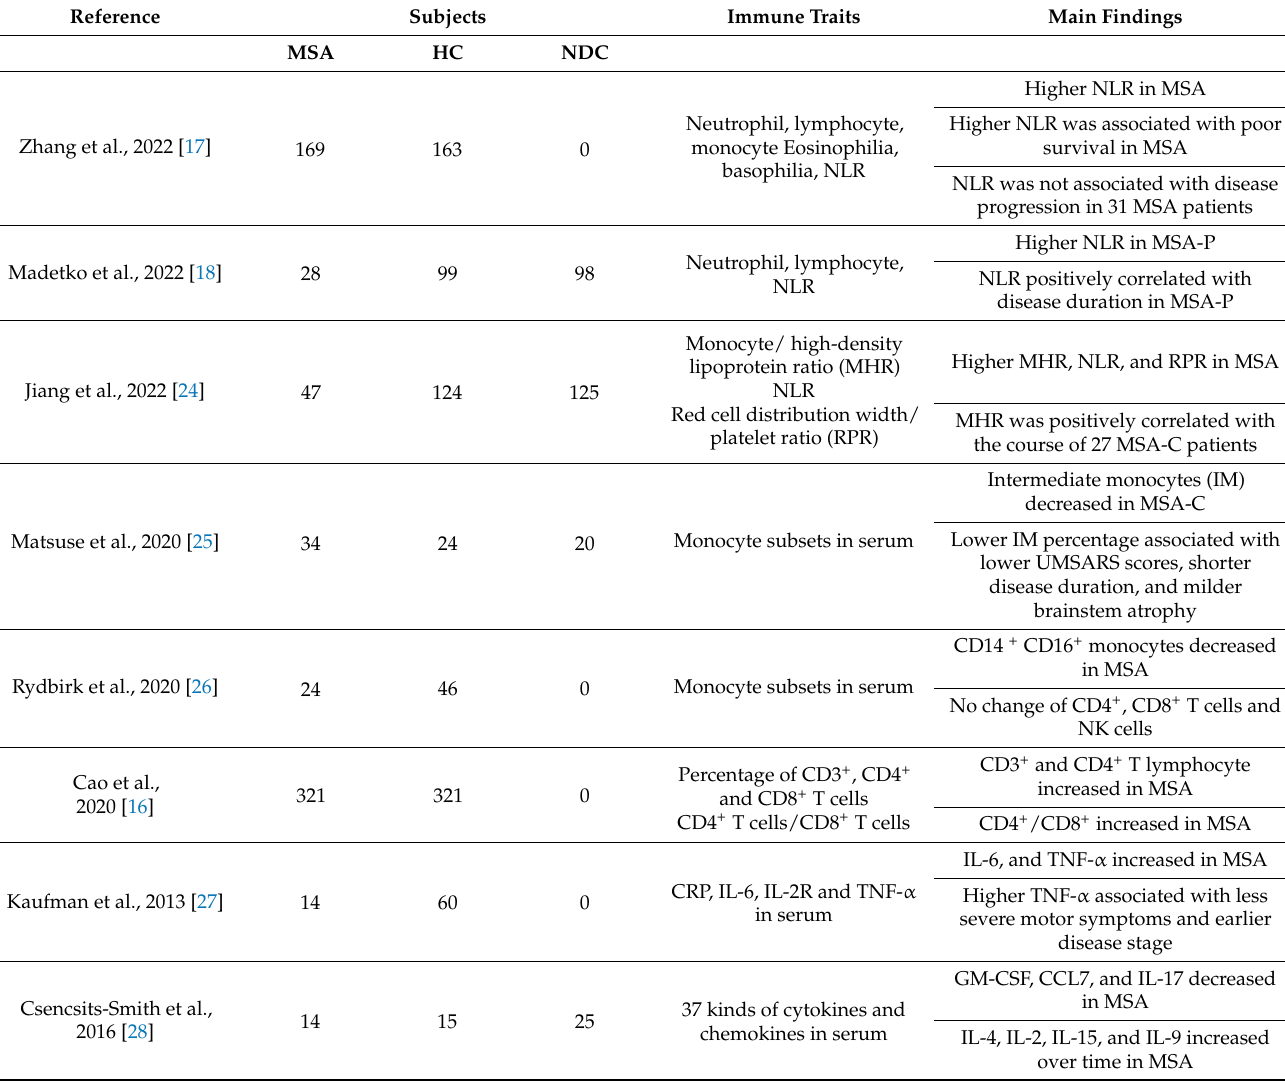
Table 1. Literature review of studies on immunity traits in patients with